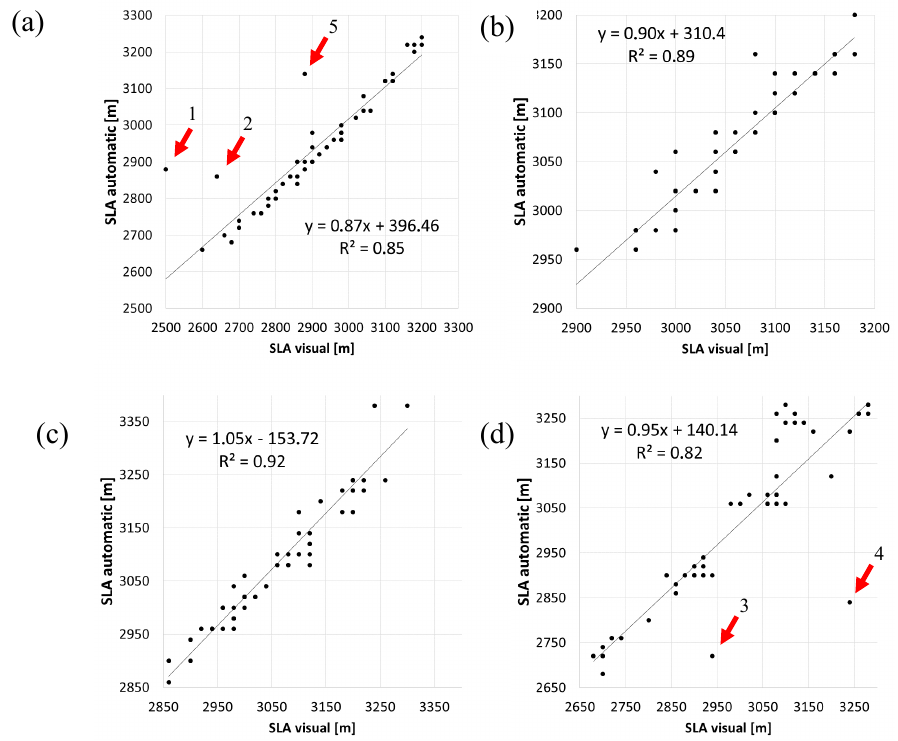
Figure 5. Visual versus automatic SLA for ( a ) HEF, ( b ) KWF, ( c ) VNF, and ( d ) HJF. For all four glaciers an r 2 > 80% is obtained. The highest variability is found for HJF.